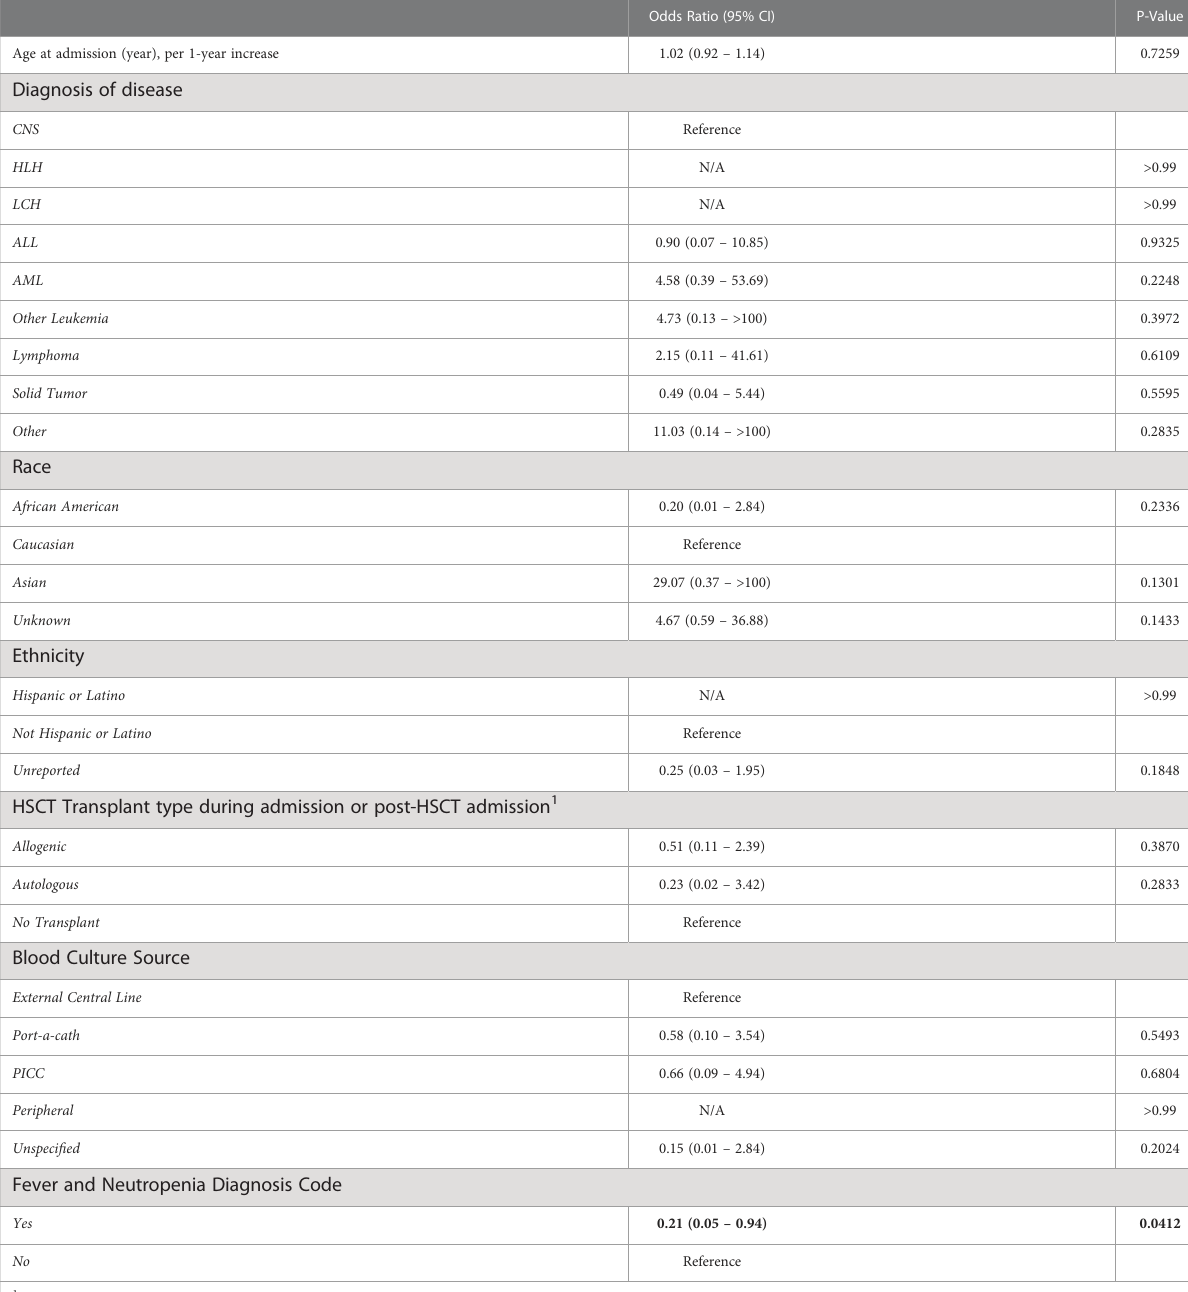
TABLE 6 Multivariable Analysis of Risk Factors Associated with Mortality during Admissions with BSI